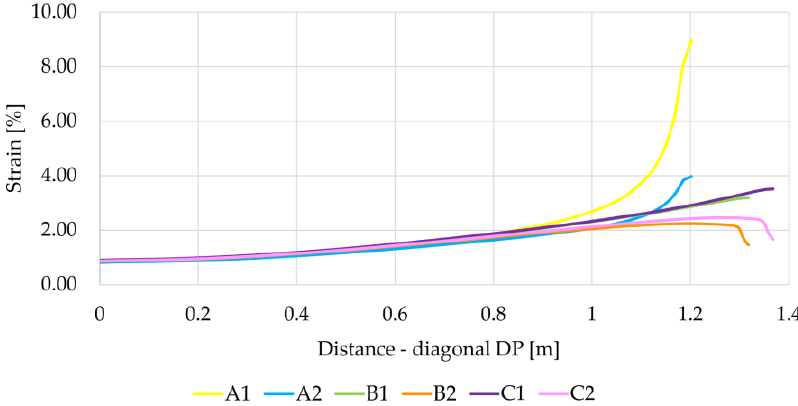
Figure 14. Reinforcement strain on the diagonal DP depending on the analyzed variant.